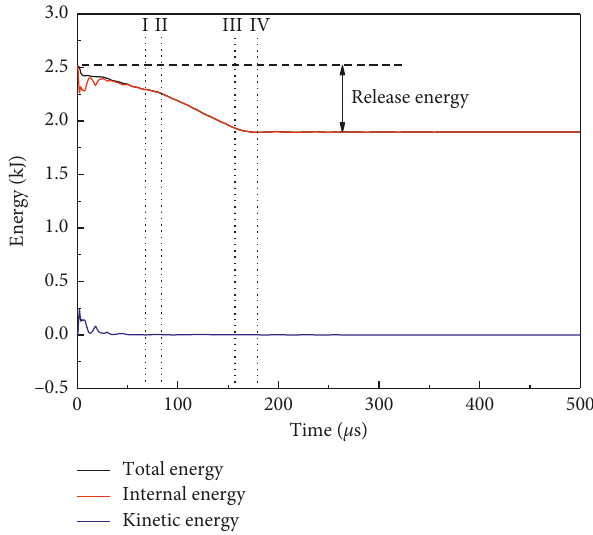
Figure 22: Energy histories of 442 ° mg charge